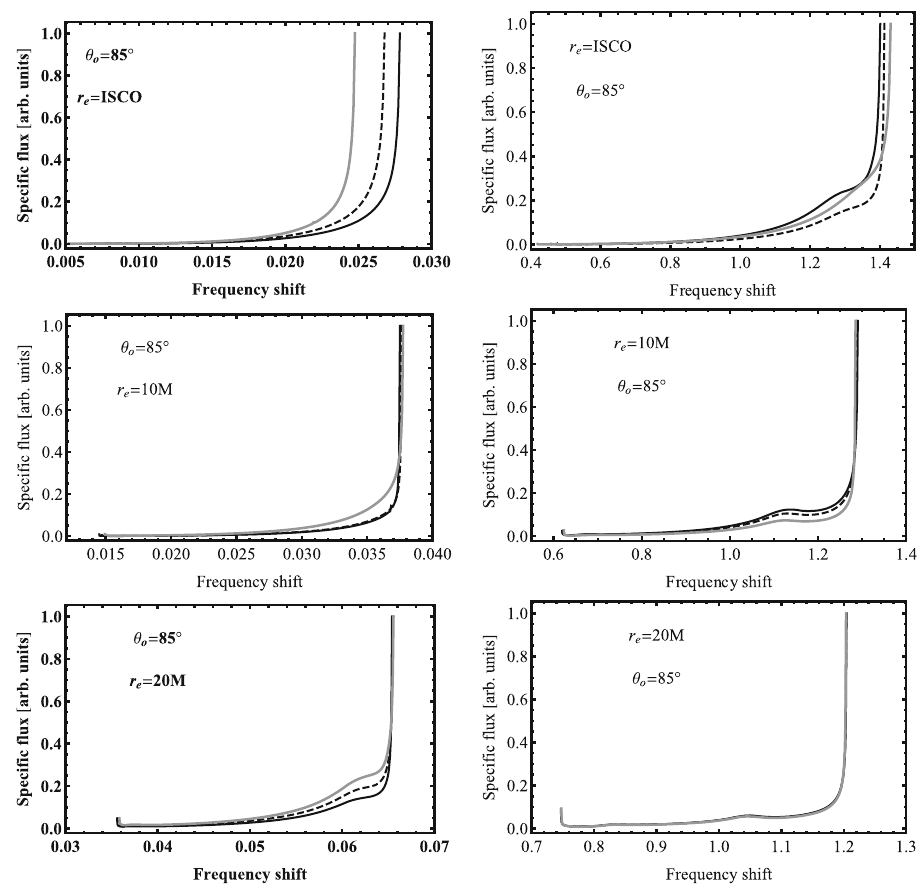
Fig. 3 Ring profiled spectral line generated for three representative values of “magnetic charge” parameter q m = 0 . 05 M (black), 0 . 5 M (black, dashed), and 0 . 768 M (thick, gray) and three Keplerian ring radii r e = r ISCO ( q m ) (top), 10 M , and 20 M (bottom). The observer inclination is θ o = 85